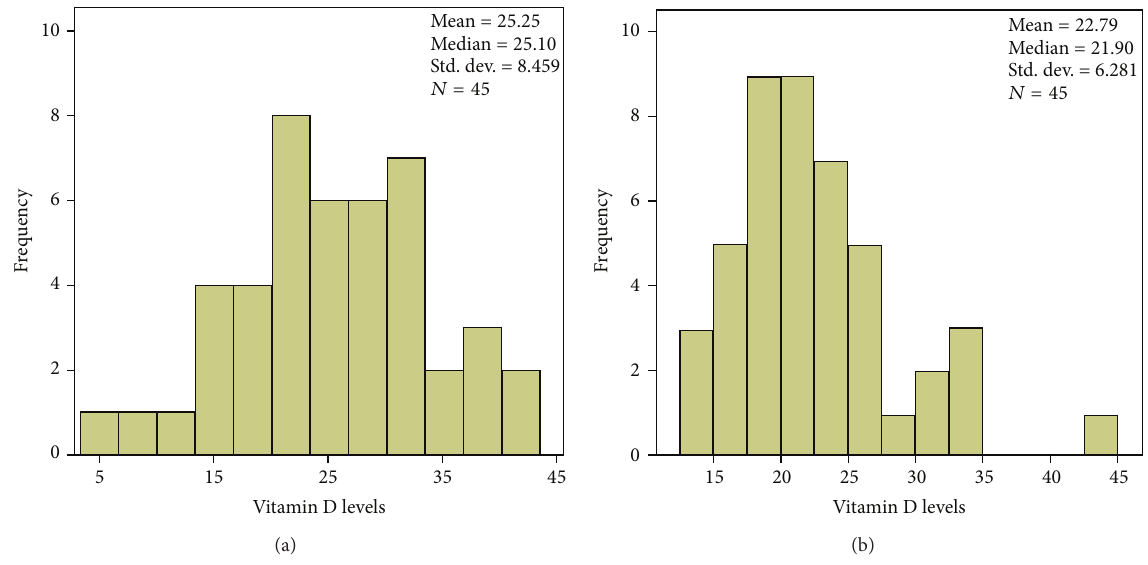
Figure 1: Histograms showing the distribution of plasma 25(OH)D levels (ng/mL) in NF1 patients (a) and controls (b).